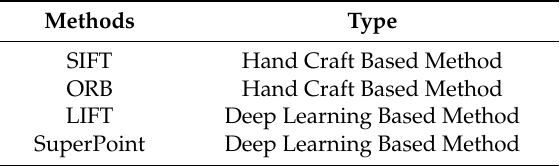
Table 2. Single-modality image matching methods.